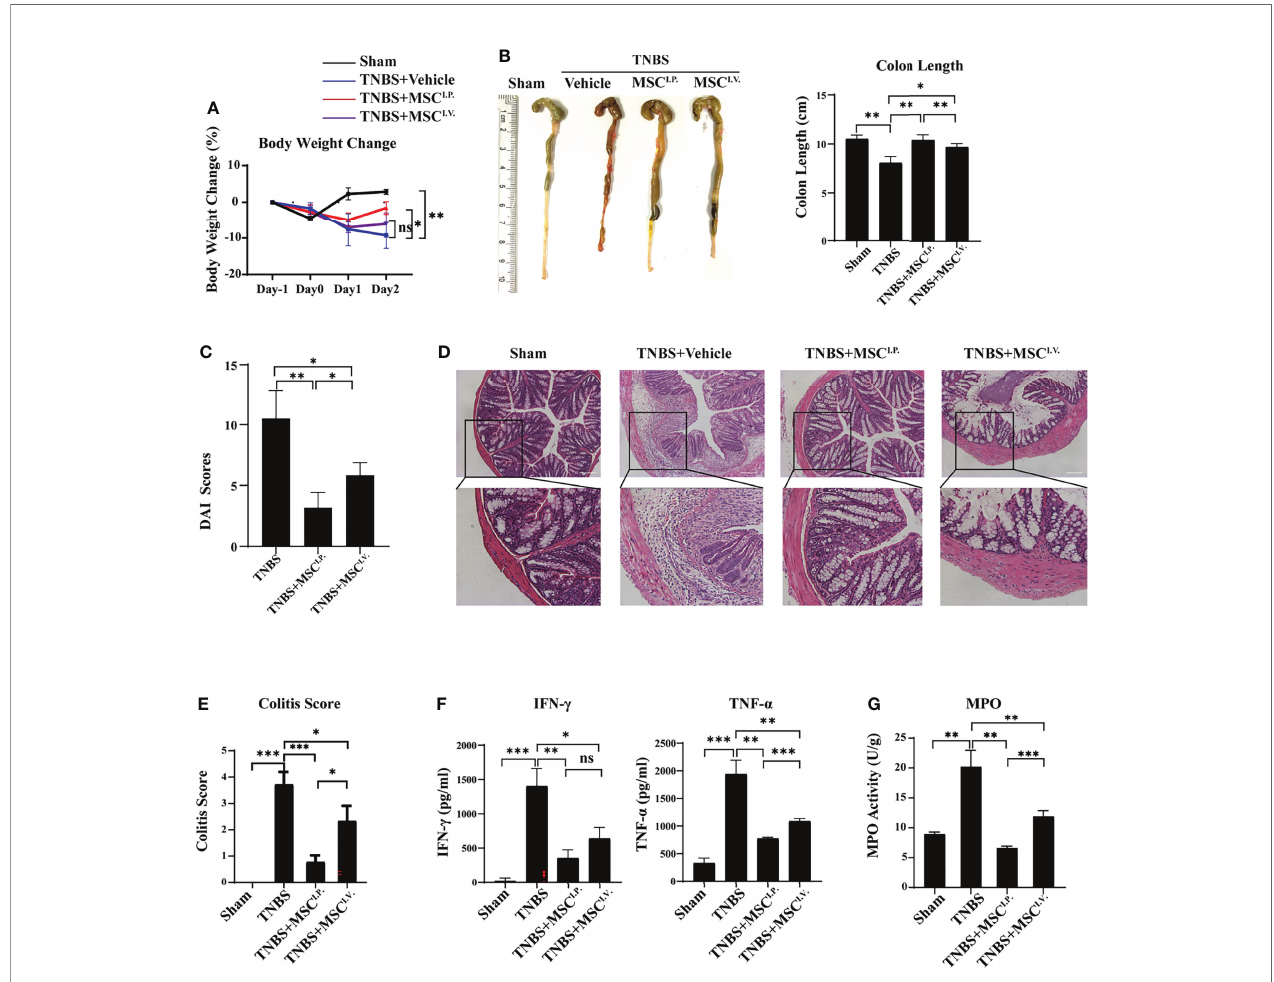
FIGURE 1 | Intraperitoneal injection of MSCs mitigates TNBS-induced colitis in mice. MSCs were administered intravenously or intraperitoneally to IBD mice, and their therapeutic effects were evaluated. (A) Comparison of body weight loss after TNBS induction. (B) Comparison of colon lengths after TNBS induction. (C) The disease activity indices (DAI) were evaluated based on scores of percentage weight loss, stool consistency, and bleeding. (D) Representative H&E staining of colon cross sections and (E) colitis histological scoring at Day 2 after TNBS administration. (F) Secretion of cytokines in colon homogenates and (G) MPO activity. Statistical signi fi cance was determined by unpaired two-sided test as the means ± SD, n ≥ 3. not signi fi cant (ns) p ≥ 0.05, *p < 0.05, **p < 0.01, ***p < 0.001, ****p < 0.0001. IL-, interleukin; TNF, tumour necrosis